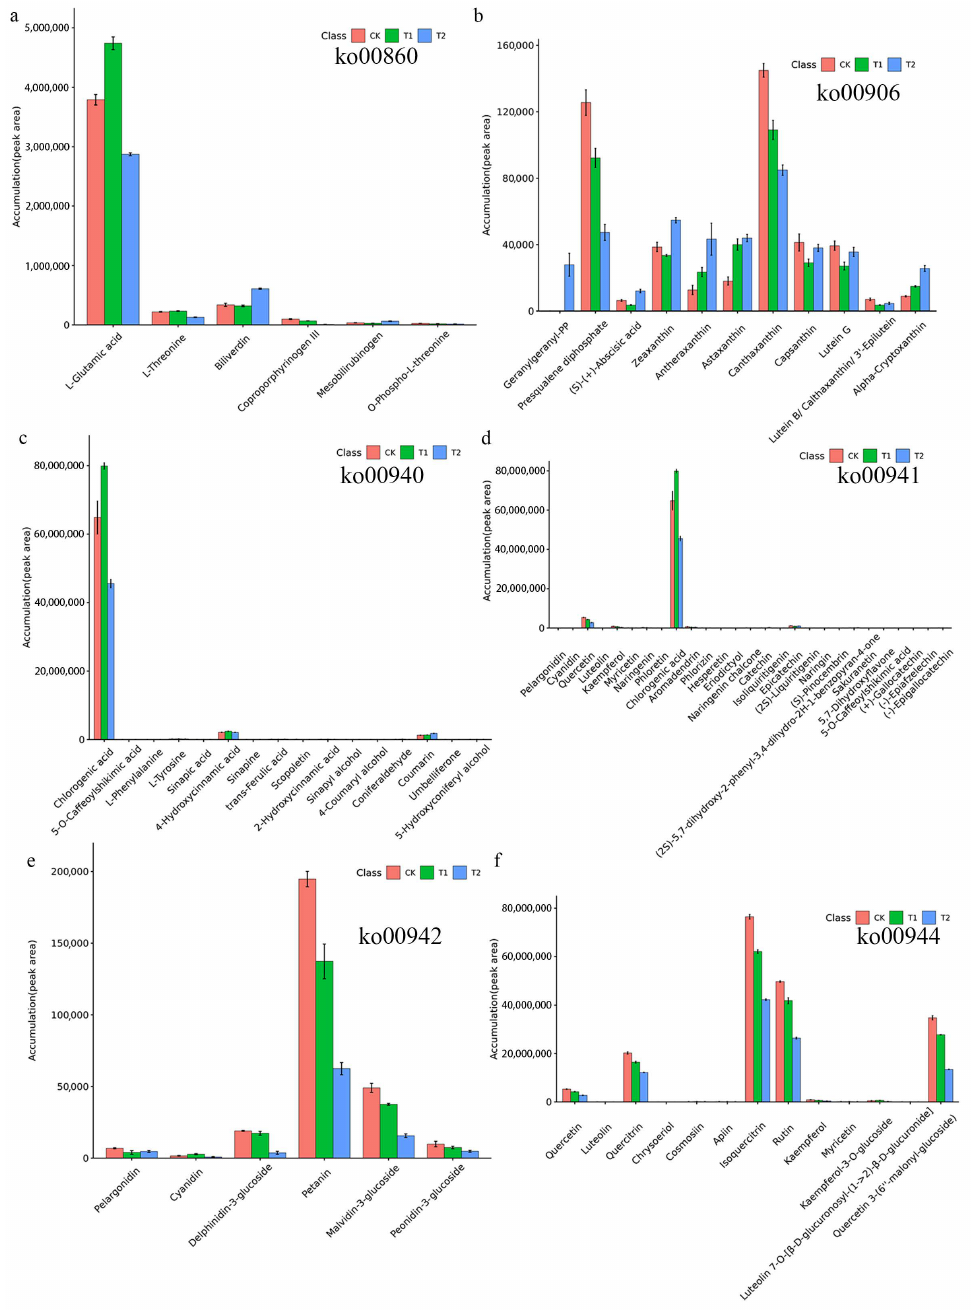
Figure 6. Analysis of the metabolites enriched in six important pathways. ( a ) Porphyrin and chloro- phyll metabolism pathway; ( b ) carotenoid biosynthesis pathway; ( c ) phenylpropanoid biosynthesis; ( d ) flavonoid biosynthesis; ( e ) anthocyanin biosynthesis pathway; and ( f ) flavone and flavonol biosynthesis